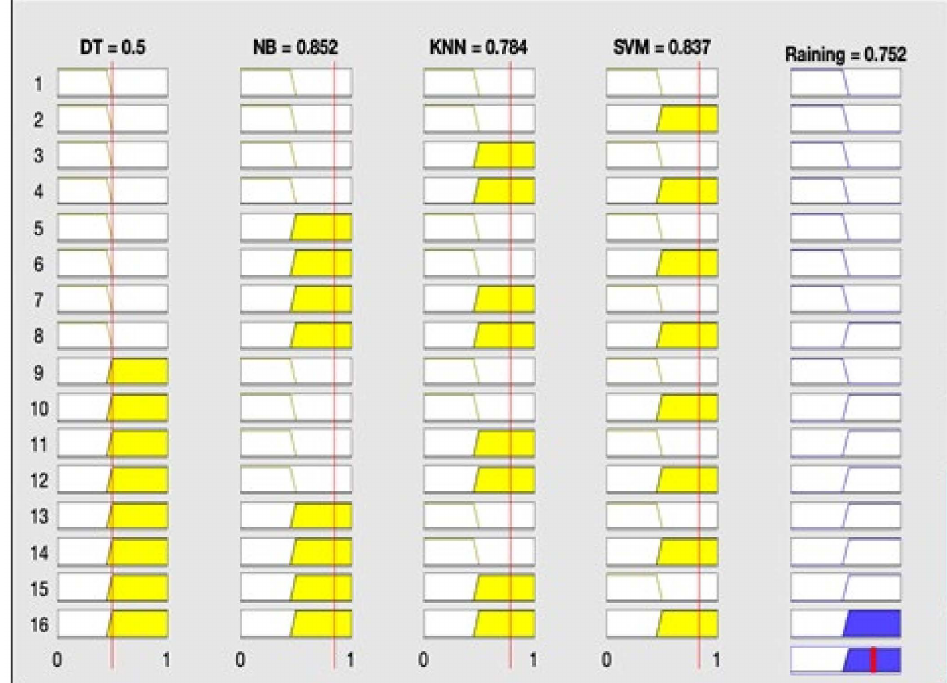
Figure 3. Result of proposed framework: rainfall = yes.